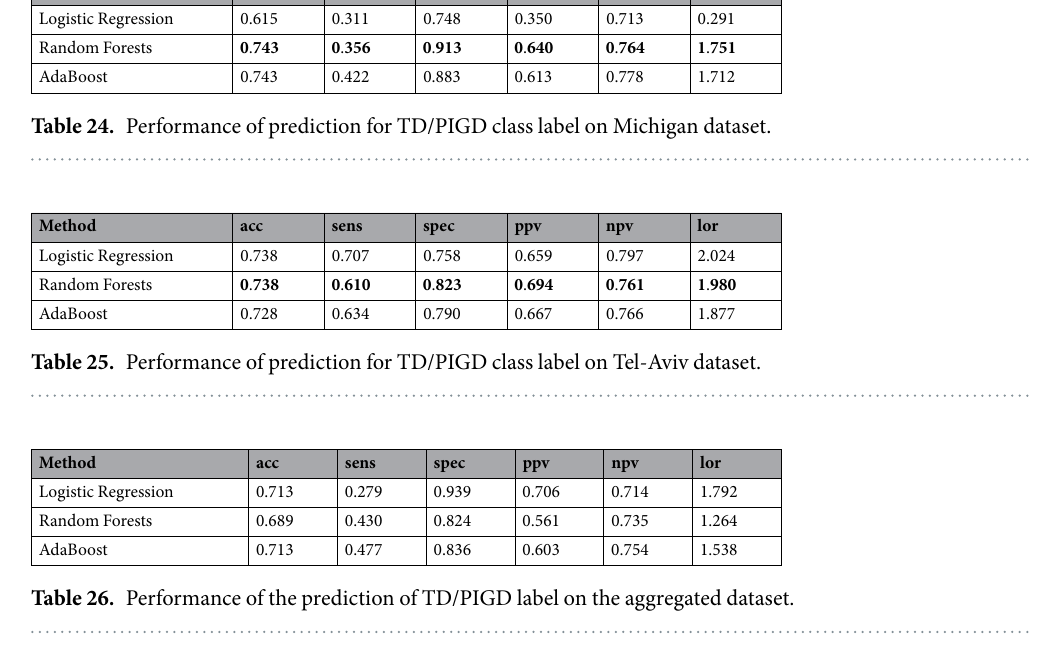
Table 23. Performance of model-based and model-free methods. Train on Tel Aviv and test on Michigan.